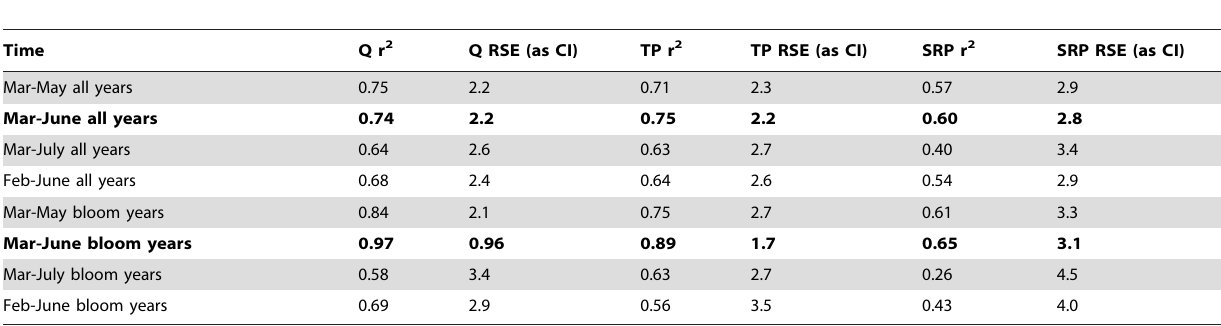
Table 3. R 2 and residual standard error (RSE) for all 10 years and bloom years between maximum CI and the combined loads of March to May, March to June (in bold), and March to July.